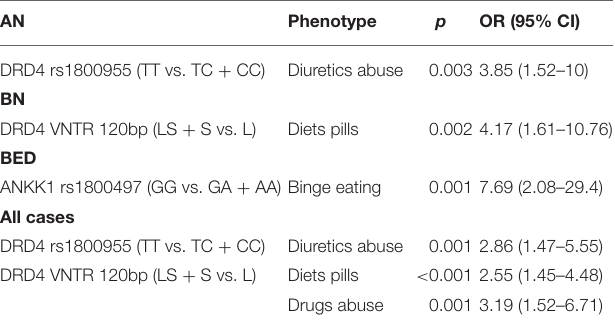
TABLE 4 | Significant findings of the genotype–phenotype correlation